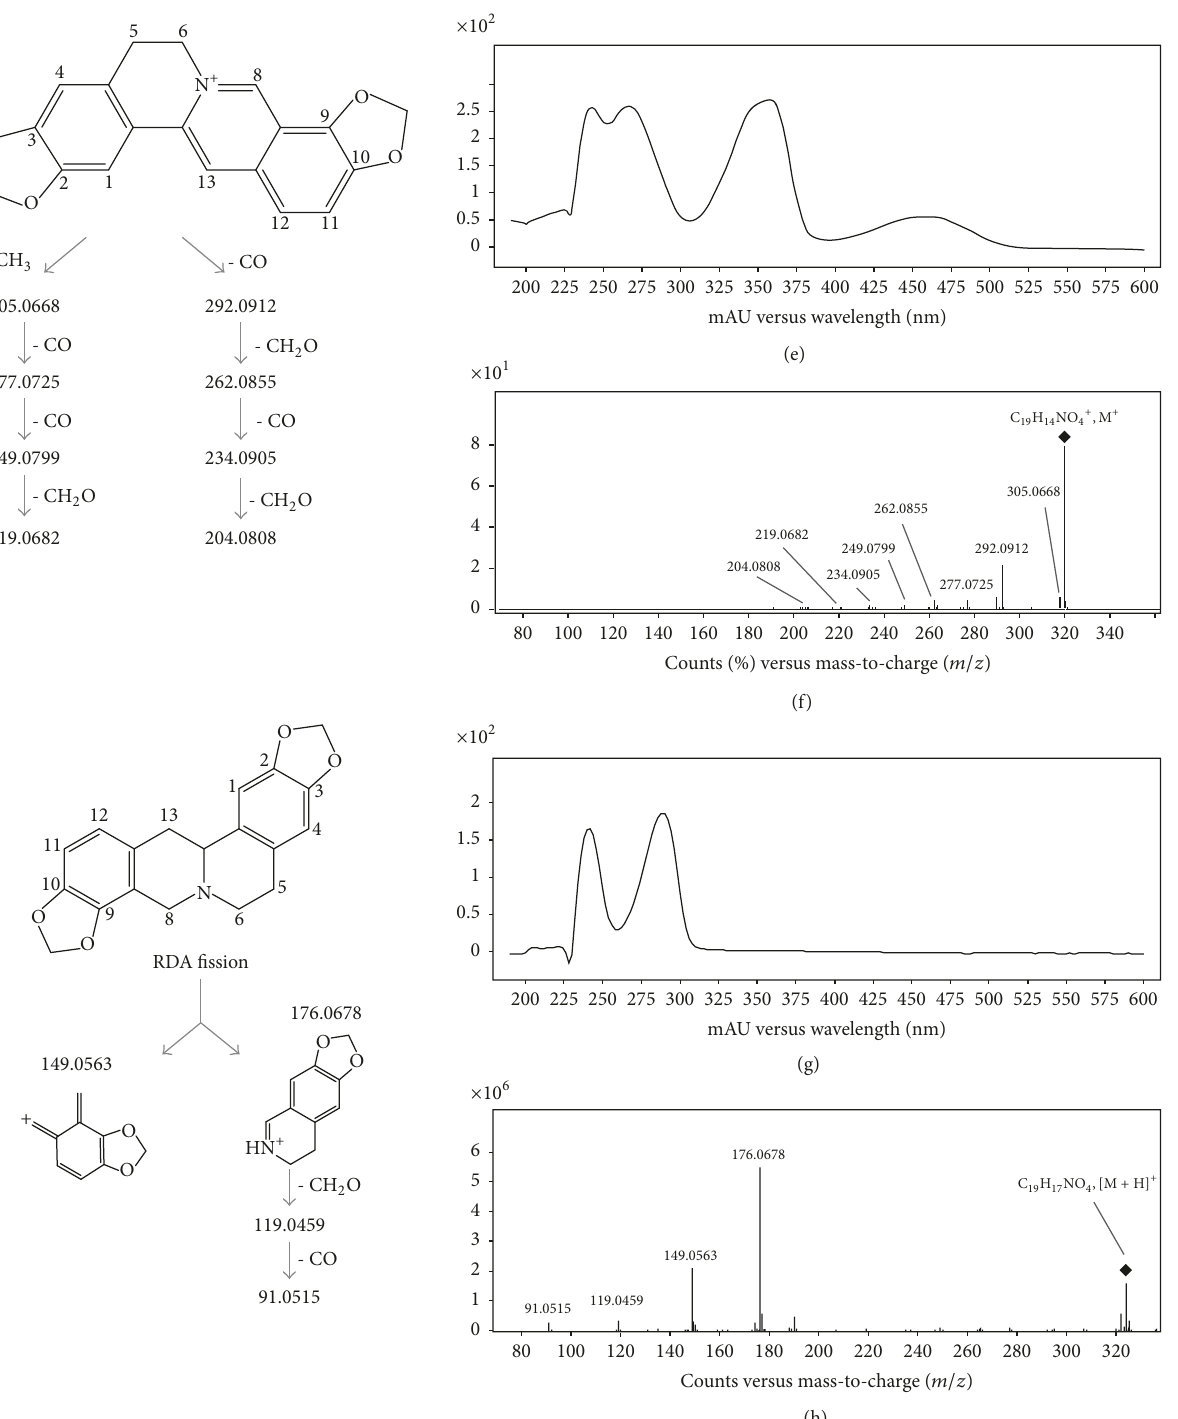
Figure 4: UV-Vis spectra and fragmentation pattern of isoboldine ((a) and (b)), protopine ((c) and (d)), coptisine ((e) and (f)), and stylopine ((g) and (h)), respectively, determined by